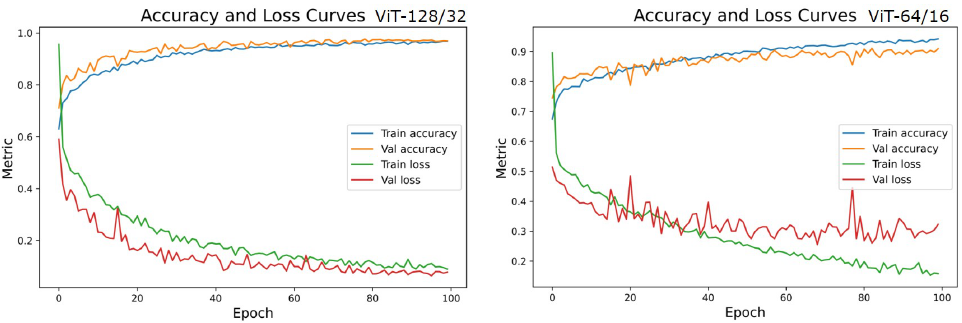
Figure 14. Accuracy and Loss curves of the two top performing model settings-ViT128/32 and ViT64/16. The real-valued and normalized confusion matrices of the two ViT variants show the proportion of each category classified (Figures 15 and 16). The best-performing model could capture better attention representations, hence the higher percentages of True Positives and True Negatives. ViT64/16 has captured attentive features from the real image class, depicting a higher number of False Negatives (real being classified as fake) compared to False Positives (fake being classified as